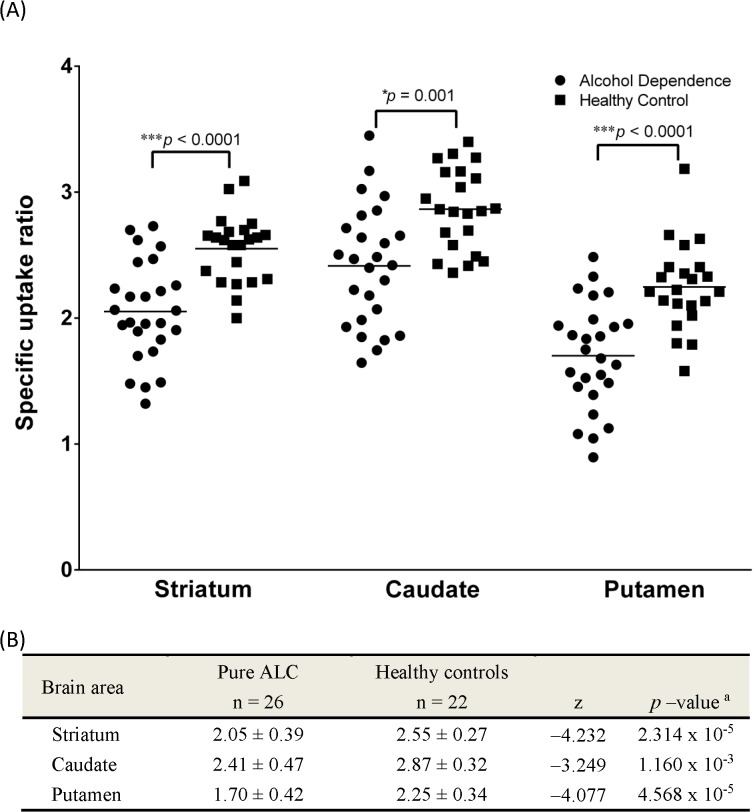
A scatter plot (A) and general data (B) of specific uptake ratio (SUR) of DAT in striatum, caudate and putamen calculated from 99mTc-TRODAT-1 SPECT in alcohol dependent subjects and healthy controls.Horizontal bars indicates mean value of SUR. (mean ± SD). a
p value of Mann-Whitney U test.